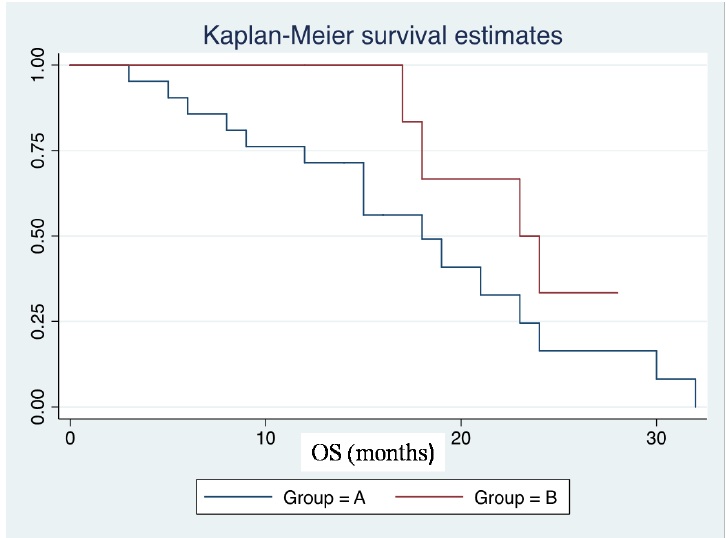
Figure 6. Group A ( n = 21): patients affected by GBM with IRS SRSF1 values ≥ 6; Group B ( n = 7): Pa- tients affected by GBM with IRS SRSF1 values < 6.